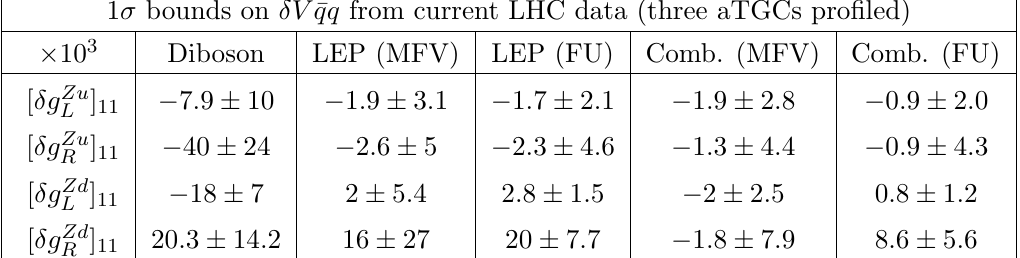
Table 2 . Constraints ( (cid:2) 10 3 ) on the (cid:14)V (cid:22) qq vertex corrections from a seven parameter global (cid:12)t combining LHC diboson data and LEP-1 measurements. The (cid:12)rst column gives the bounds using the LHC diboson data alone. The second and third columns report the LEP-1 bounds derived in ref. [27] under the MFV and FU assumptions respectively. Finally, the last two columns show the combination of the current LHC and LEP-1 data for the two (cid:13)avour assumptions.